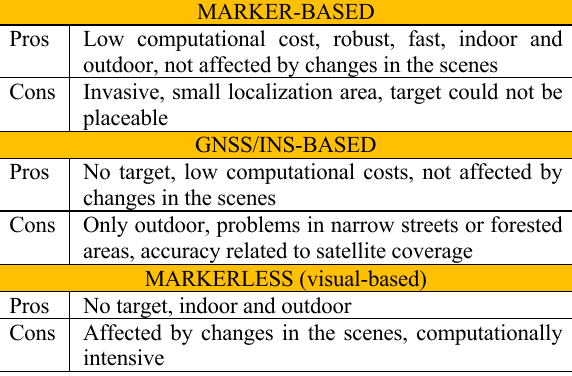
Table 1. Summary of tracking & localization methods for